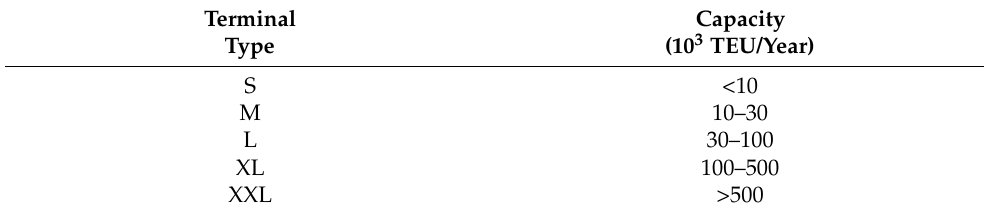
Figure 2. Services provided by an intermodal rail terminal. (Source: https://www.intermodal- terminals.eu/intermodal-terminals, accessed on 6 September 2021). Table 1. Types of intermodal rail terminals.